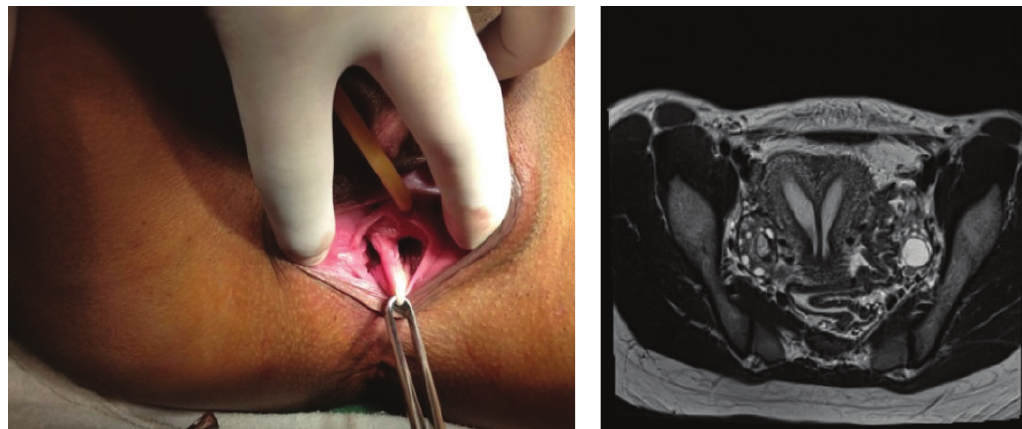
Figure 1: Complete septum evidenced two vaginal cavities (left). Pelvic image of magnetic resonance imaging showing septate uterus